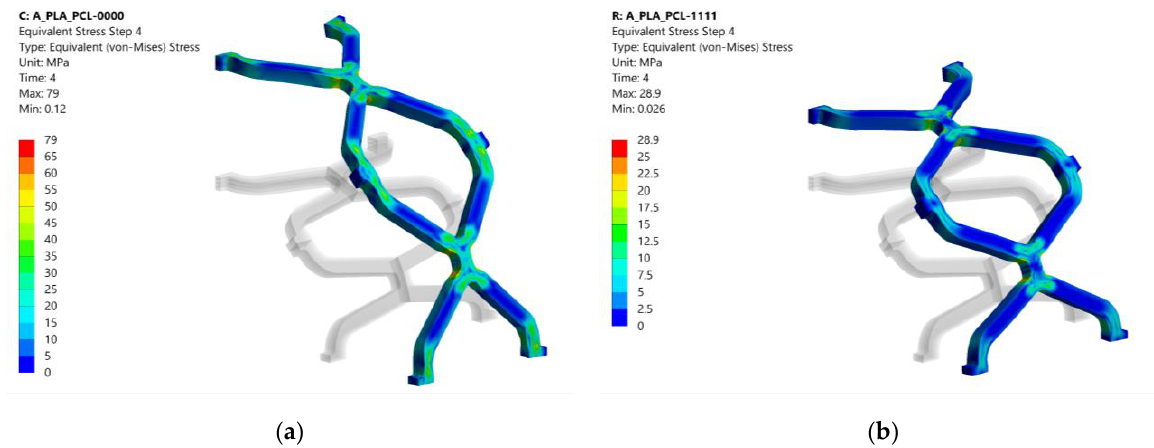
Figure 7. Equivalent (von Mises) stress results in MPa after the last numerical analysis step for configurations 0000 and 1111 (deformation scale factor: 1): ( a ) residual stress after balloon removal for configuration 0000; ( b ) residual stress after balloon removal for configuration 1111.